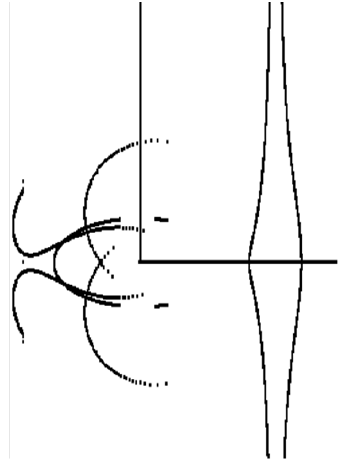
Figure 3. q = 1, KG = 60, and DK = 200.